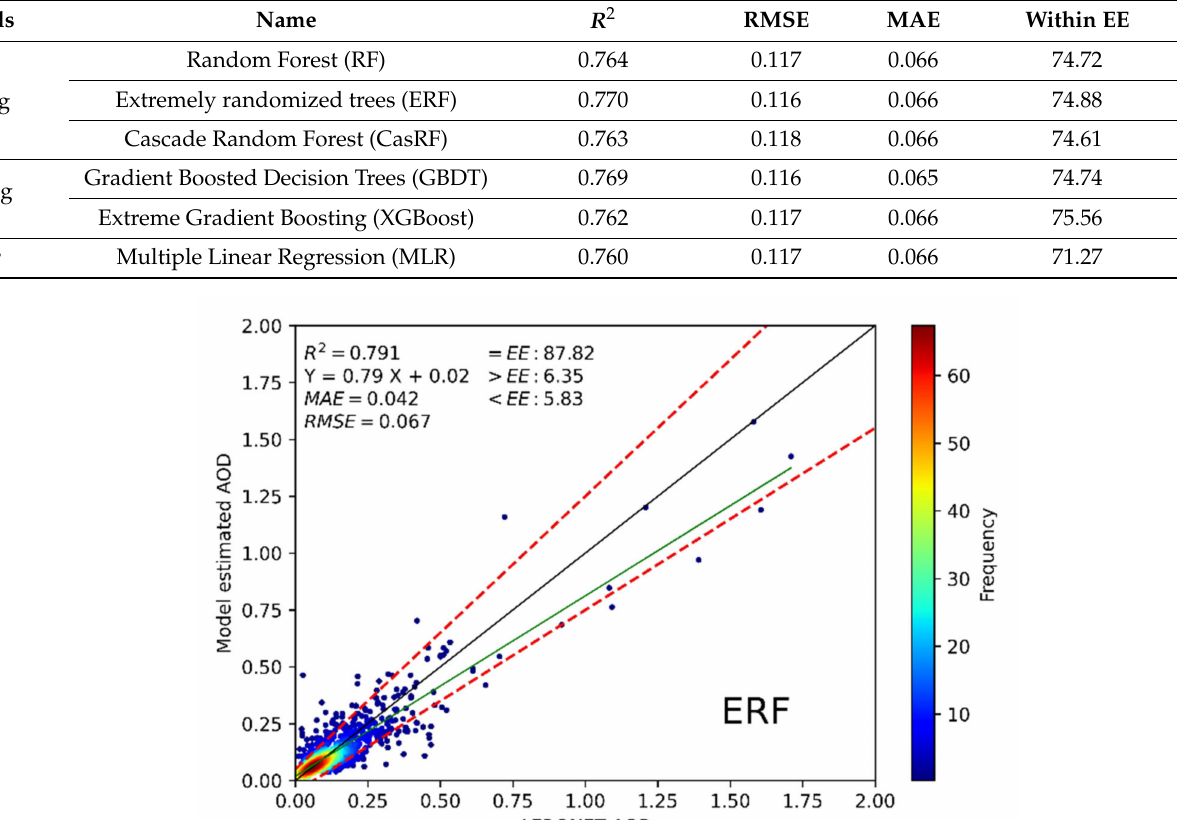
Table 4. Independent validation results for the different machine learning models.